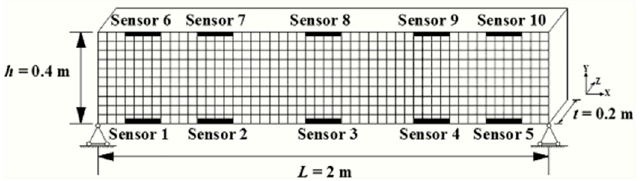
Figure 1. Finite element model of a simply supported beam for simulations with ten strain sensors installed.